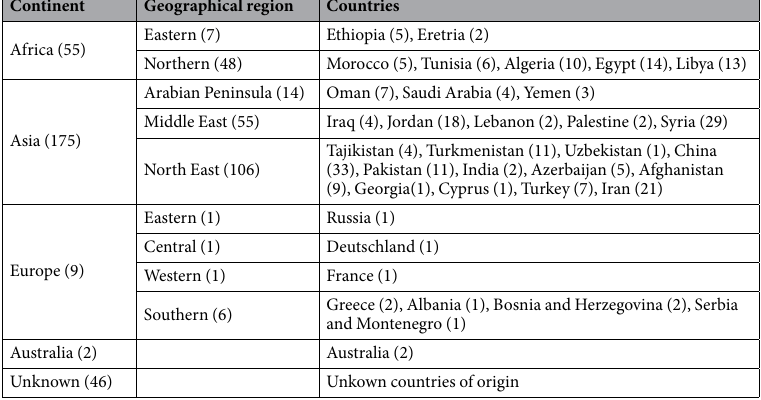
Evaluation of drought tolerance related traits. As described by Varshney et al . 53 , 227 barley accessions were grown in the 2004–2005 grown season at two locations in Syria—Tel Hadya (36°01 ′ N; 37°20 ′ E, elevation 300 m asl, long term average annual rainfall = 338 mm) and Breda (35°56 ′ N; 37°10 ′ E, elevation 354 m asl, long term average annual rainfall = 269 mm). Tel Hadya represented a favorable condition and Breda represented a drought stressed environment. Field plots were arranged in a row and column grid (10 rows, 28 columns). Trials were sown on 3 m 2 plots with 1.2 m wide (4 rows 30 cm apart) and 2.5 m long under rainfed conditions. Rainfall at the growing season was 303 mm at Tel Hadya and 268 mm at Breda. Phenotypic data were recorded for seven developmental and yield-related traits: days to heading (DH in days), growth vigour (GV 1 = good to 5 = bad), plant height (PH in cm), spike length (SL in cm), 1000 kernel weight (TKW in g), grain yield (GY in kg/ha) and total above ground biomass dry yield (BY in kg/ha) as described in Varshney et al . 53 . These phenotypic traits were tested for correlations using SPSS 16.0 software (SPSS Inc., Chicago, IL, USA). Phenotypic scores of measured traits are listed in Table 5. PCR amplification and EcoTILLING assays. Natural variations in barley HvP5CS1 were screened using EcoTILLING techniques. The primers were designed according to the mRNA sequence of HvP5CS1 (GenBank:AK251855.1) with melting temperatures around 60 °C by using Primer 5.0 software (Premier Biosoft International, Palo Alto, CA, USA). The DNA region amplified by the primer pair is around 1065 bp, which includes a 3 ′ -UTR and small coding sequence interrupted by three introns (Fig. 1). The forward primer labeled with IRDye700 at 5 ′ -end and the reverse primer labeled with IRDye800 at 5 ′ -end were synthesized by LI-COR Inc. (Lincoln, NE, USA). The accession ICARDA IG 138264 (drought sensitive) was selected as a reference accession. PCR amplifi- cation of the target region was performed in a volume of 10 μ l containing a mix of 10 ng each of reference and sample genomic DNAs. Heteroduplex formation, heteroduplex digestion, and denaturing polyacrylamide gel electrophoresis were performed as described by Xia et al . 54 . During electrophoresis, the LI-COR DNA Analyzer captured two images in IRD700 and IRD800 channels, respectively. Tiff images were manually scored using GelBuddy program 55 . Big dark bands of different sizes in both IRD700 and IRD800 channels were considered a polymorphic site (Supplementary Fig. S3). Total length PCR products from both channels should be equivalent to the fragment size of the undigested PCR product. Samples were grouped into putative haplotype categories based on the cleaved banding pattern in evaluated gel-frames. DNA sequencing and statistical analysis. Once a polymorphism in a barley accession was identified, the corresponding DNA sample was amplified with the primers used in EcoTILLING. The resulting PCR fragment was directly sequenced to confirm the polymorphisms. Each polymorphic site was sequenced from more than one accession that showed the polymorphism in the same site to confirm that only two alleles segregated at the specific site. Multiple sequence alignment was conducted using ClustalW software 56 . Nucleotide diversity ( π ), haplotype diversity, Tajima’s D 57 and D * and F * values 58 were calculated using DnaSP v5.0 59 . PIC was calculated as described in Kota et al . 60 . Population structure analysis. The barley germplasm collection was structured into geographical groups in which some individuals are possibly related, so background genetic effects must be controlled to avoid spurious associations. Incorporating structure components as covariates in association analysis helps to reduce the false associations 61 . All of the accessions were genotyped using 21 SSR markers assigned to seven chromosomes in barley (Supplementary Table S4). Amplification of the SSRs was carried out as described by Hayden et al . 62 . Amplified PCR products were analyzed in the LI-COR 4300 DNA analyzer (LI-COR, Lincoln NE, USA) and scored by comparing sizes between PCR products and a molecular weight ladder. Data from the 21 SSR markers were used to determine the population structure using the STRUCTURE software version 2.3.3 63, 64 . The program was run